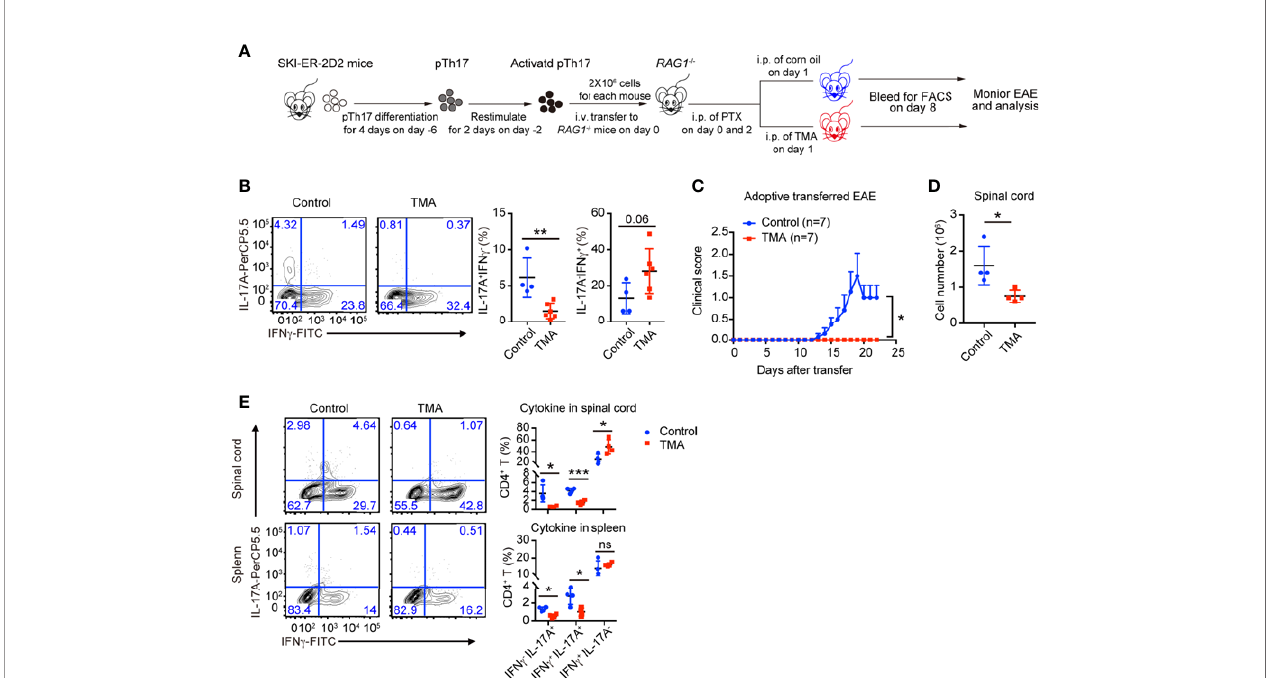
FIGURE 5 | Induced SKI expression disrupted the in vivo maintenance of pathogenic Th17 cells and ameliorated pathogenic Th17 cells-elicited EAE. (A) Schematic diagram of testing the in vivo maintenance and function of SKI-ER-2D2 pathogenic Th17 cells using adoptive T cell transfer model. (B) Flow-cytometry of IFN g - or IL-17A- producing CD4 + T cells from blood of Rag1 − / − recipient mice transferred with SKI-ER-2D2 pTh17 cells and treated with tamoxifen (TMA) or vehicle control (Control) for 8 – 10 days. Left, representative plot; right, composite data, n = 4 mice for control group, n = 6 for TMA group of two independent experiments; means ± s.d., ns, not signi fi cant p > 0.05, **p < 0.01, by two-sided Student ’ s t -test. (C) The EAE clinical scores of the mice that received SKI-ER-2D2 pTh17 cells and treated with tamoxifen (TMA) or vehicle control (Control). The data were from two independent experiments; n = 7 mice in each group, mean ± s.e.m., *p <0.05 per two-way multiple-range ANOVA test. (D) Cellularity of in fi ltrating cells in spinal cords of EAE mice with tamoxifen (TMA) or vehicle control (Control) treatment at day 22 after EAE elicitation. Data are pooled offour mice per group from two independent experiments; means ± s.e.m.; * P < 0.05, by two-sided Student ’ s t -test. (E) The population of IFN g -, IL-17A- producing CD4 + T cells in spinal cords (upper) and spleens (bottom) from mice at day 22 of adoptive transferred induced EAE. The results were representative of two independent experiments; n = 4 mice, mean ± s.d., ns, not signi fi cant p > 0.05, * p < 0.05, ***p < 0.001 by two-sided Student ’ s t